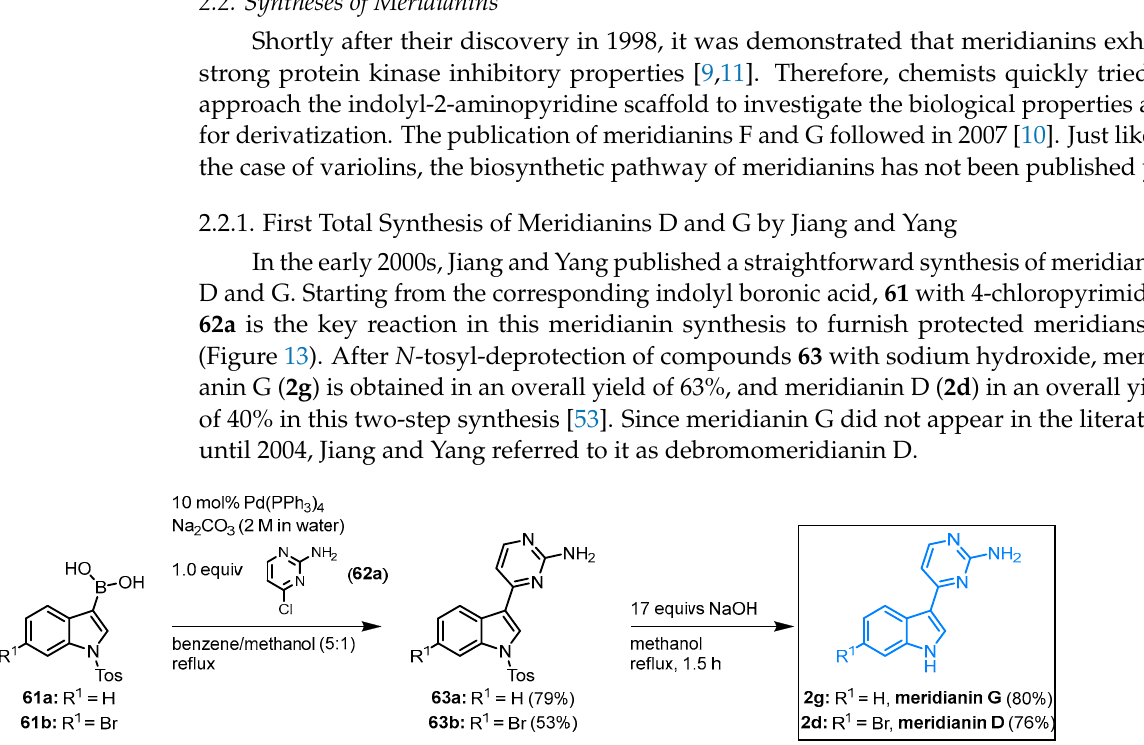
Figure 13. First synthesis of meridianins D and G [53].